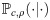
Exome {y1, y2, …}, which gives amino acid sequence {a1, a2, …}, undergoes specific somatic mutations through transformation Pc,ρ(·|·) and results in {y˜1,y˜2,…} which, in turn, gives amino acid sequence {a˜1,a˜2,…}.